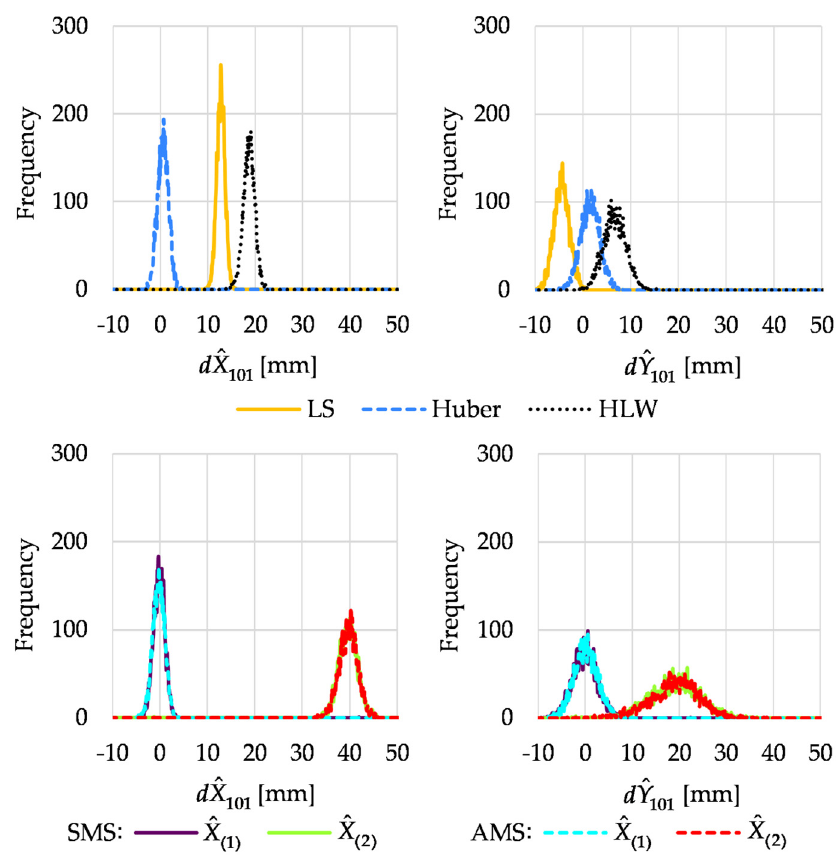
Figure 7. Histograms of estimated increments to point 101 coordinates in Variant I.